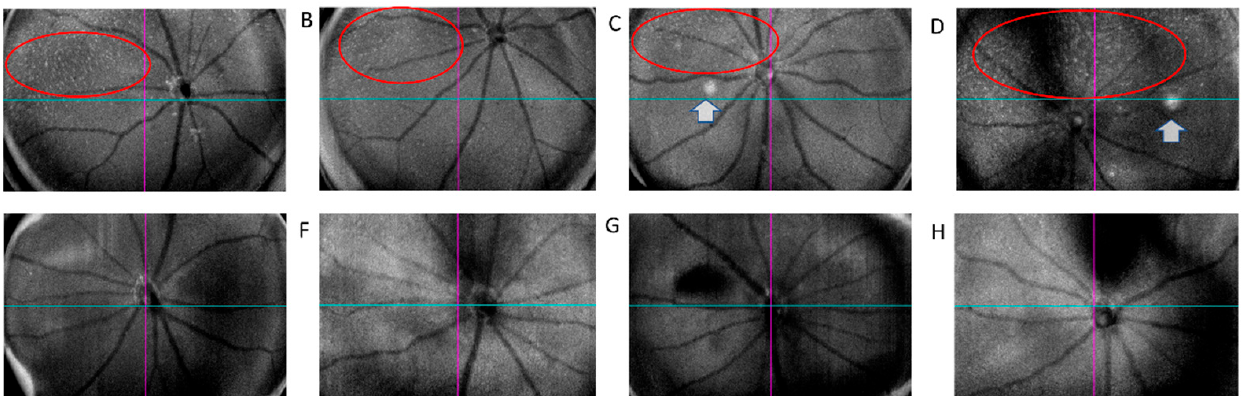
Figure 3. In vivo imaging of mice retina and choroidal plexus. Representative angiographic ( A – F ) and corresponding structural ( G – L ) images from HtrA1 mice (27 months) of OCTA. Images from the superficial plexus slab ( A , G ), avascular slab ( B , H ), deep inner plexus slab ( C , I ), choriocapillaris slab ( D , J ), ORCC slab ( E , K ), and the choroid slab ( F , L ). Image of deep retinal plexus ( I ) indicates the selected area (white arrow) of the cross B section scan image with flow signal in red ( M ). B scan failed to show vascularization corresponding to the Type-1 lesion ( G – I ).